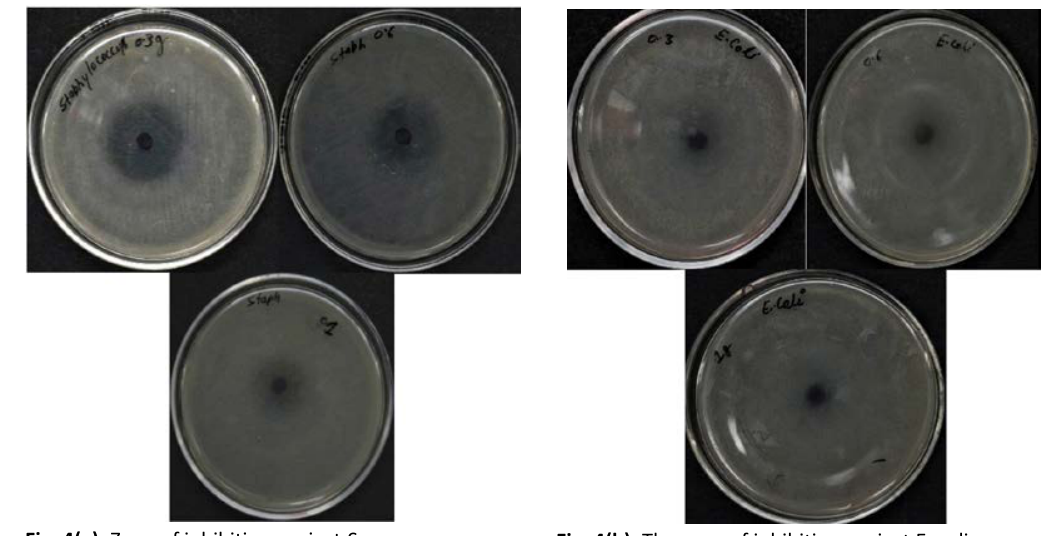
Fig. 4(a). Zone of inhibition against S. aureus Fig. 4(b). The zone of inhibition against E.